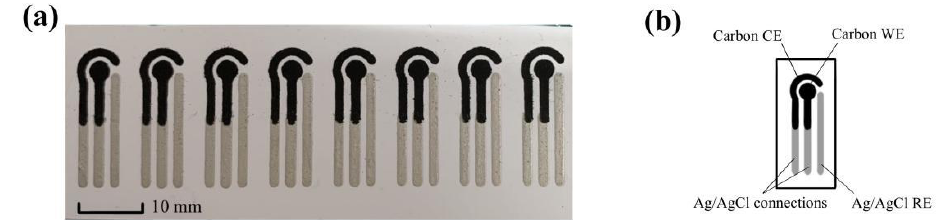
Figure 1. ( a ) Design of the glucose sensor. ( b ) Schematic illustration of a single module with three electrodes.